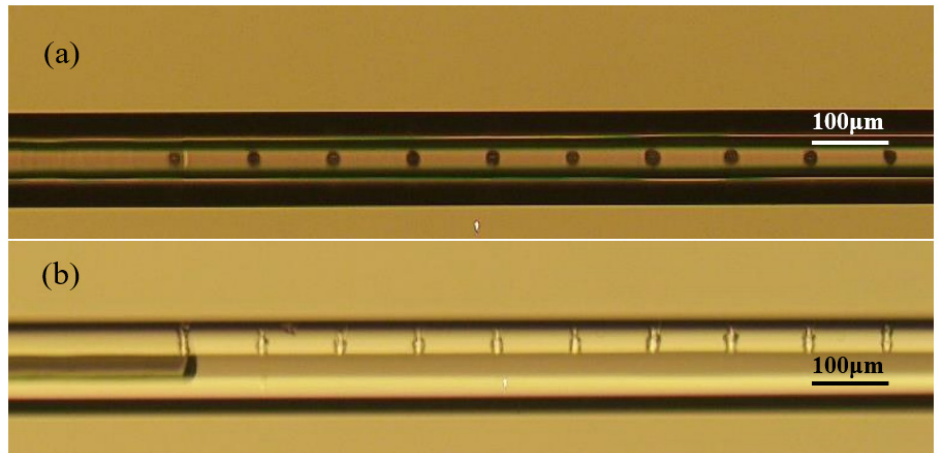
Figure 4. Microscopic images of ten micro-holes drilled in an HCF. ( a ) Front view; ( b ) Side view.